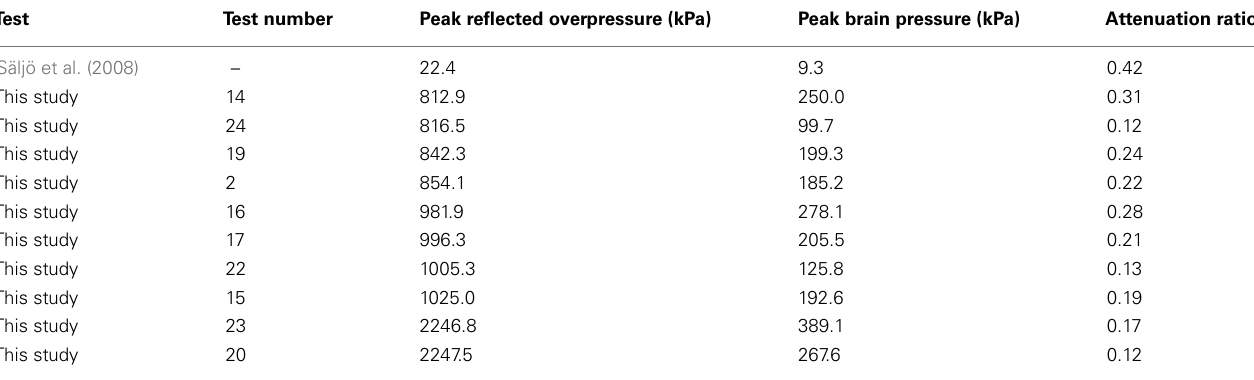
Table 4 |The shock exposure compared to the maximum pressure measured in the brain for tests in this study compared to those in prior literature (Säljö et al.,